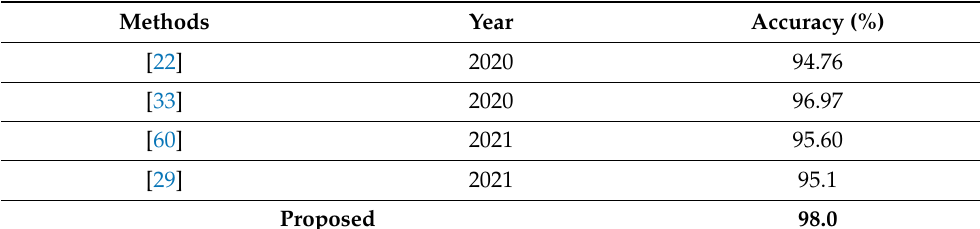
Table 5. Comparison with existing techniques for COVID-19 classification.